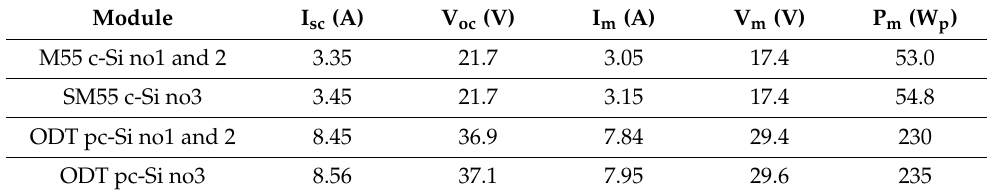
Table 1. Nominal values of c-Si and pc-Si modules used in the diagnostics